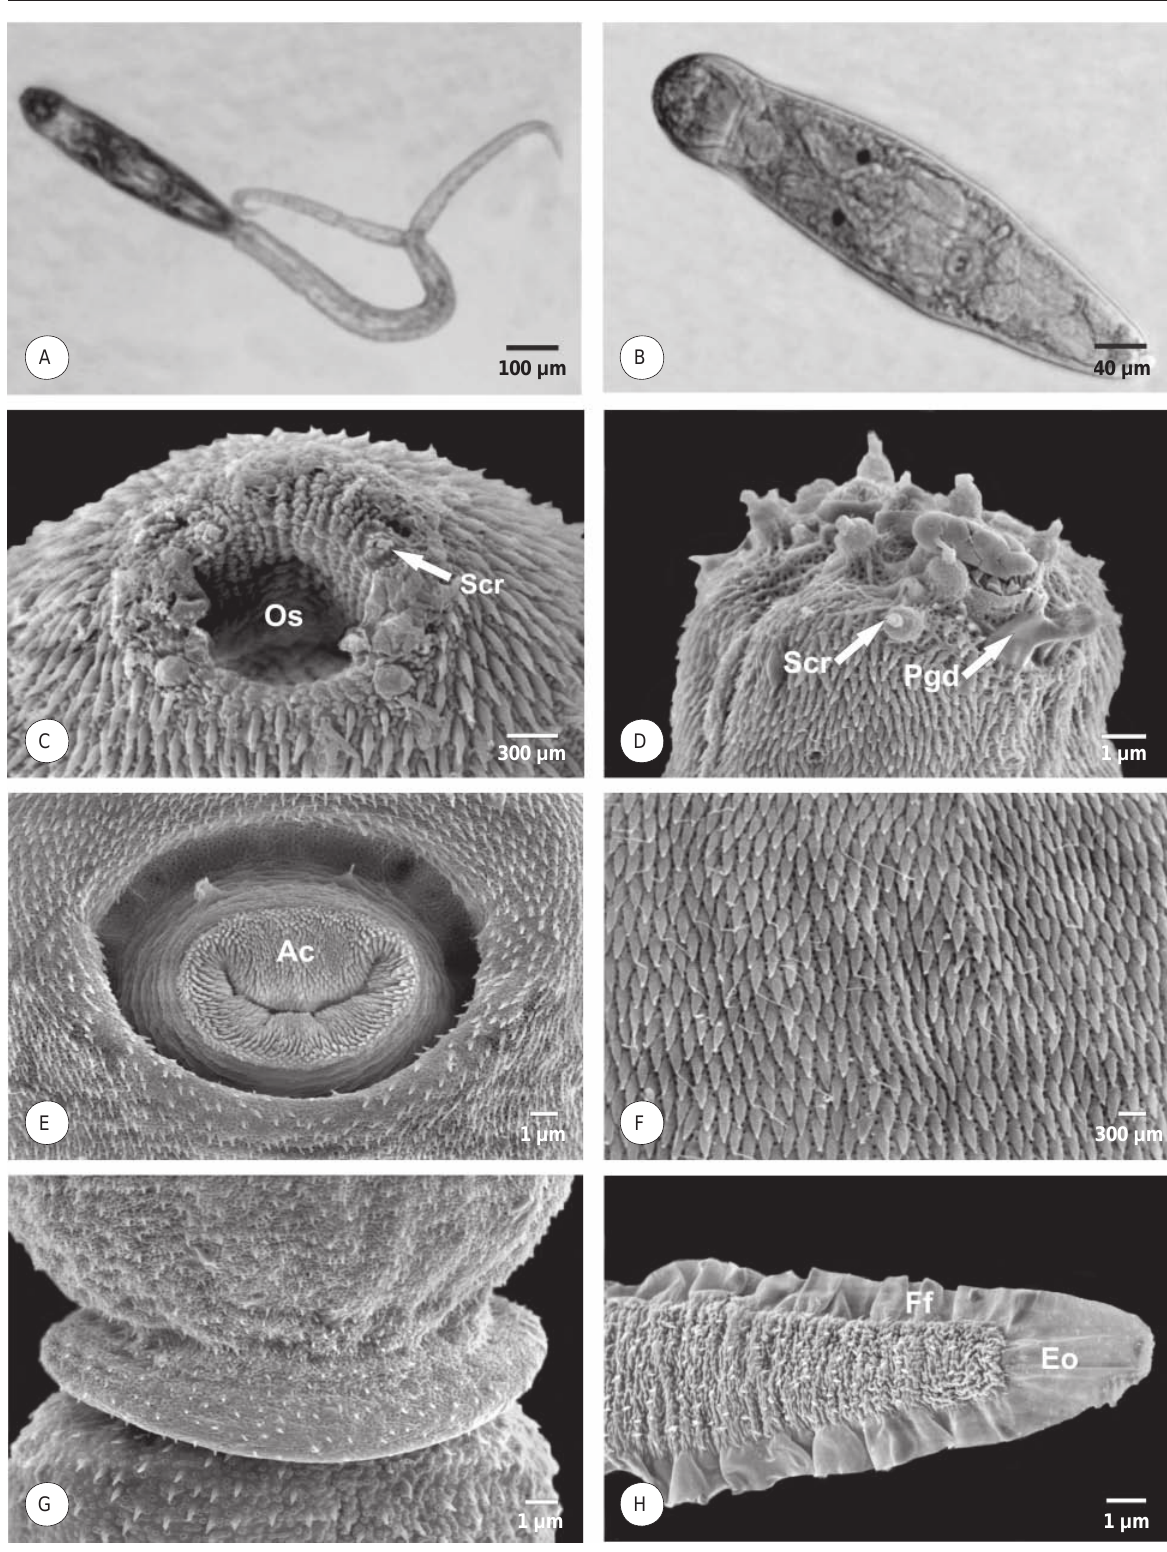
FIG. 2 Apharyngeal-brevifurcate distome cercaria. Light micrographs of (A) whole mount; (B) head of cercaria; (C–H) scanning electron micrographs of cercaria: (C) oral sucker (Os) surrounded by sensory receptors (Scr); (D) sensory receptors (Scr) and penetration gland ducts (Pgd); (E) acetabulum (Ac); (F) tegumental features of body; (G) tegument features of body posteriorly and tail; (H) tail with finfold (Ff) and excretory opening